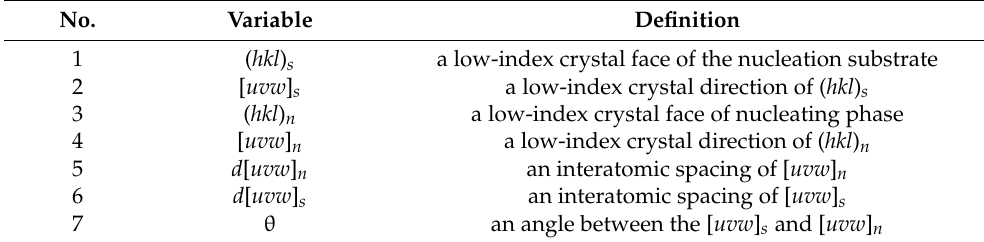
Table 6. The variable definition of the Bramfitt lattice misfit.